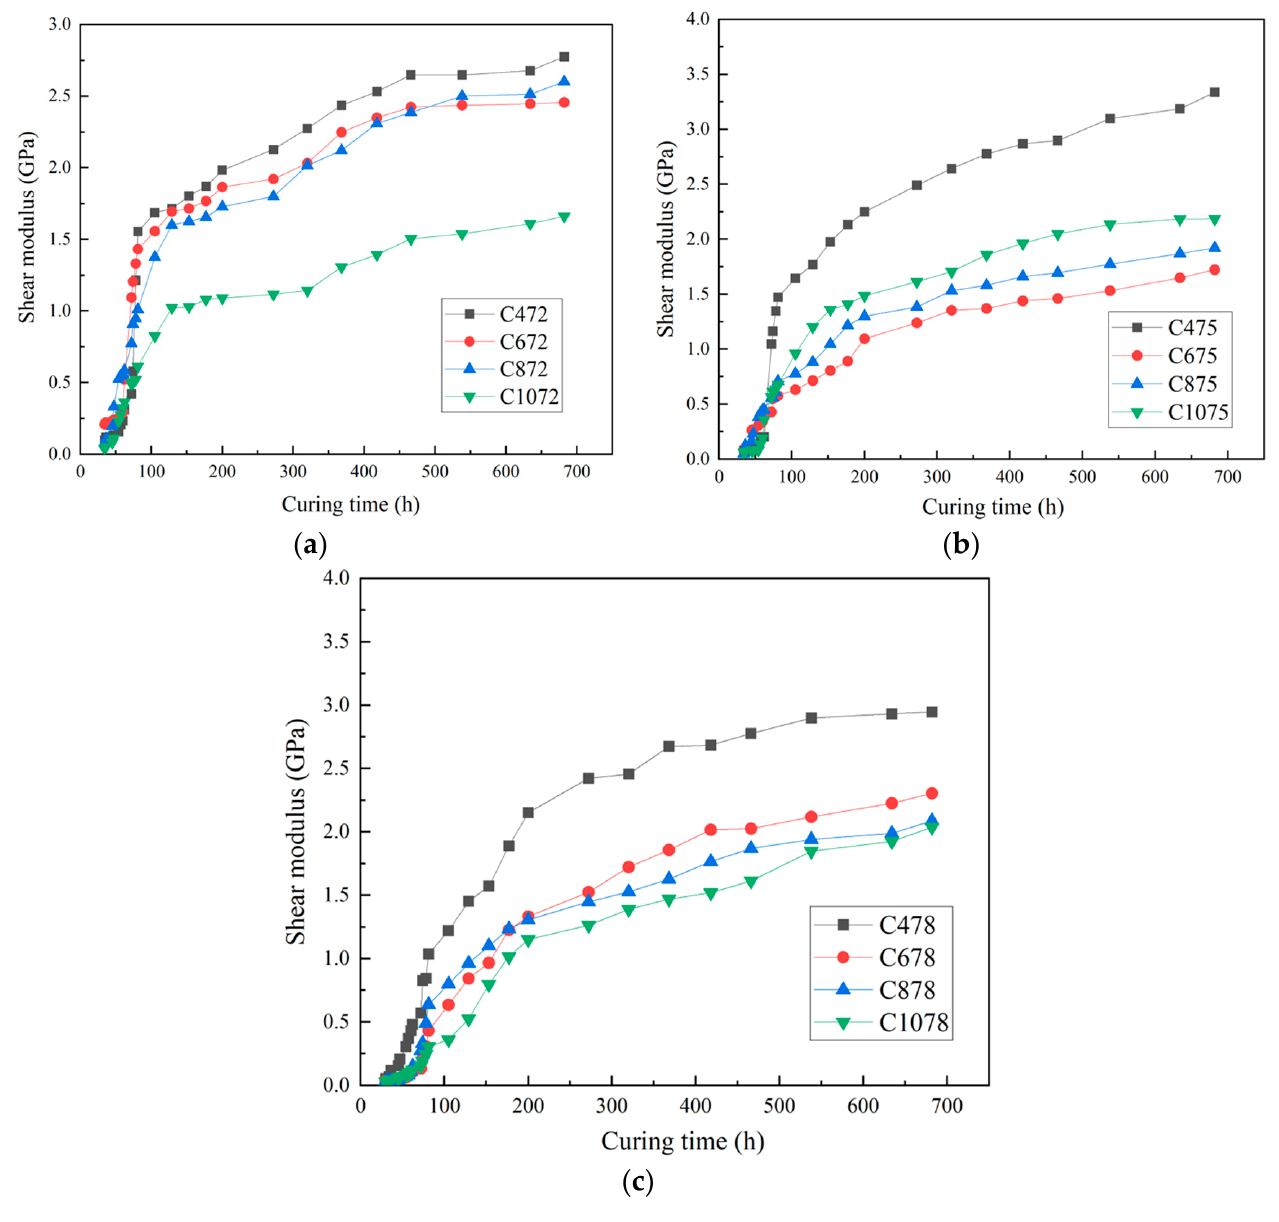
Figure 7. Development of DSM of CTB samples: ( a ) DSM, solid content of 72%; ( b ) DSM ,solid content of 75% ( c ) DSM ,solid content of 78%.